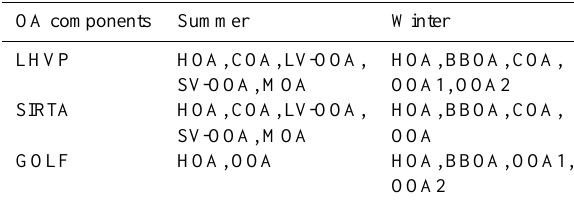
Table 2. OA components identified by the PMF analysis in each site during the MEGAPOLI summer and winter